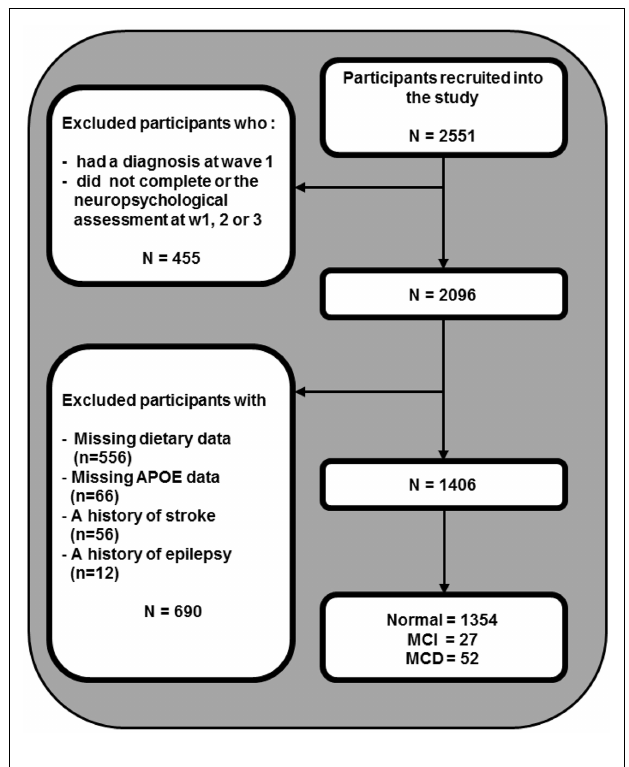
FIGURE 1 | Sample selection